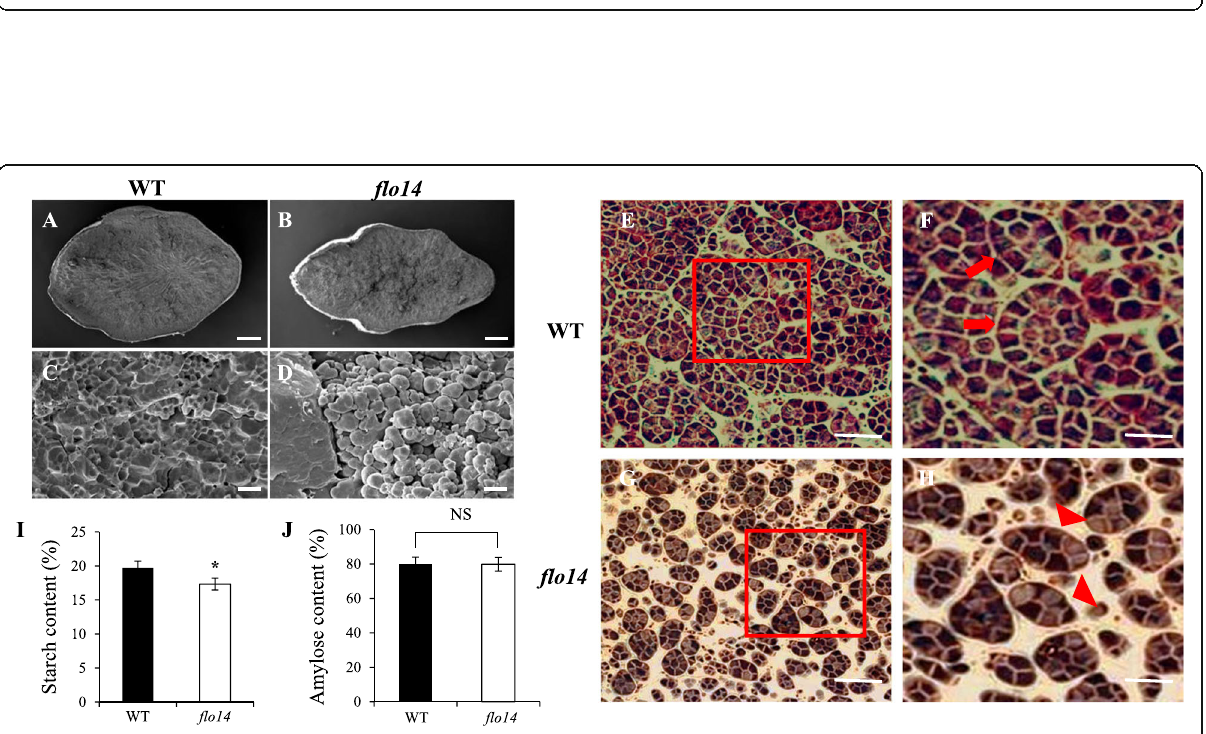
Fig. 1 Phenotypic characterization of the flo14 mutant. a Comparison of wild-type (WT) and flo14 mutant ( flo14 ) seeds. b Cross sections of wild-type and flo14 mutant seeds. c Vertical-sections of imbibed embryos of wild type and flo14 mutant. d Tetrazolium assay of wild-type and flo14 mutant seeds. e Young seedlings of wild type and flo14 mutant at 5days after germination. f Thousand kernel weight of wild-type and flo14 mutant seeds. Data indicate means ± SD (from at least three independent samples) and was compared with wild type by Student ’ s t -test (* P < 0.05, ** P < 0.01). Scale bars: 1mm in ( a and b ), 1 cm in ( c and d ), 500 μ m in ( e )